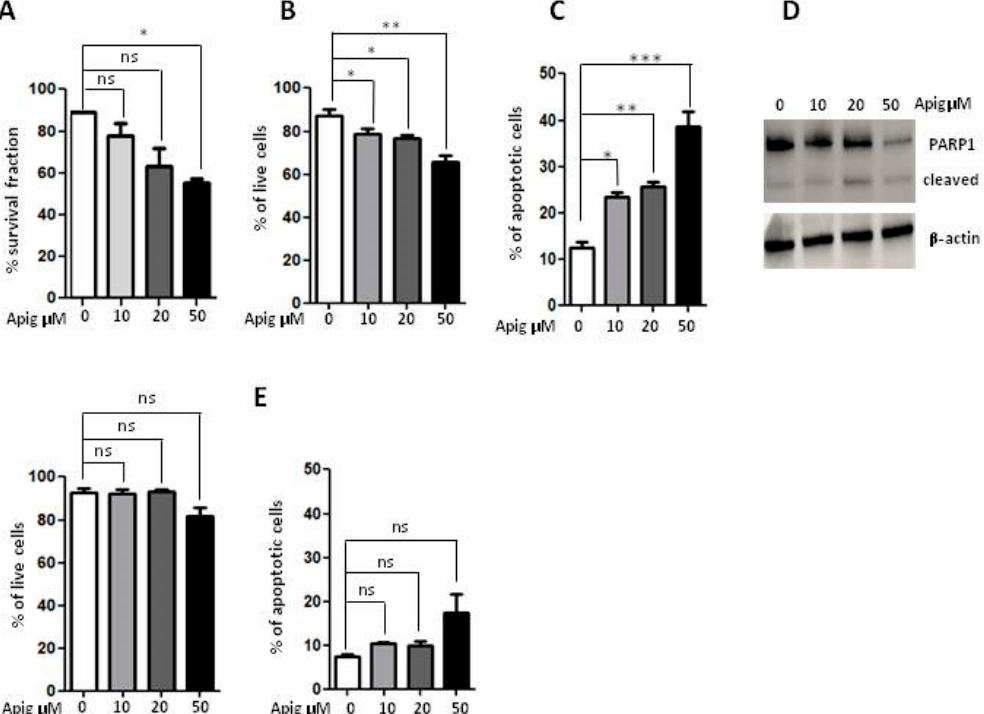
Figure 1. ( A ) Analysis of cellular viability with MTT survival experiment in human A673 ES cells after 24 h of treatment with apigenin (10-20-50 µ M); ( B ) Percentage of live cells after Viobility TM Fixable Dyes assay after 24 h of treatment with apigenin (10-20-50 µ M); ( C ) The apoptotic e ff ect of apigenin analysed after 24 h of treatment (10-20-50 µ M); ( D ) Western Blot analysis of PARP1 enzyme after treatment with apigenin (10-20-50 µ M) with β -actin as loading control; ( E ) Percentage of live cells after Viobility TM Fixable Dyes assay and apoptotic e ff ect on healthy lymphocytes after 24 h of treatment with apigenin